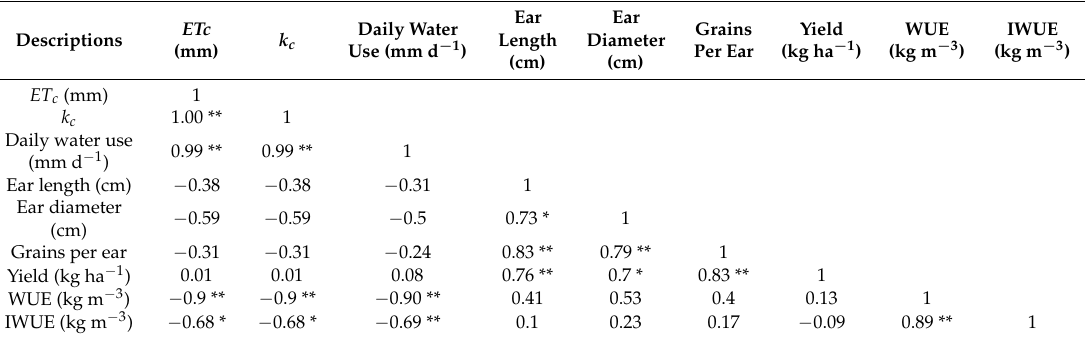
Table 7. Pearson correlations among water use characteristics and yield components.